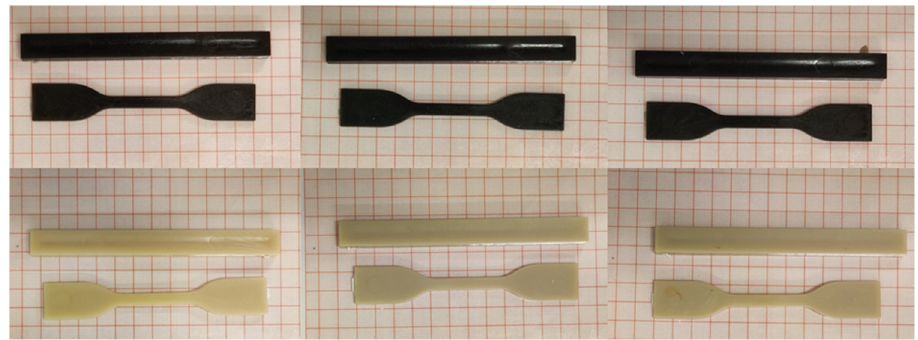
Figure 2. Injection-molded tensile and impact test specimens. ( Top row Left – Right ) PLA90%BF10% after 1, 3 and 6 recycling steps; ( Bo tt om row Left – Right ) PLA90%HNT10% after 1, 3 and 6 recycling.